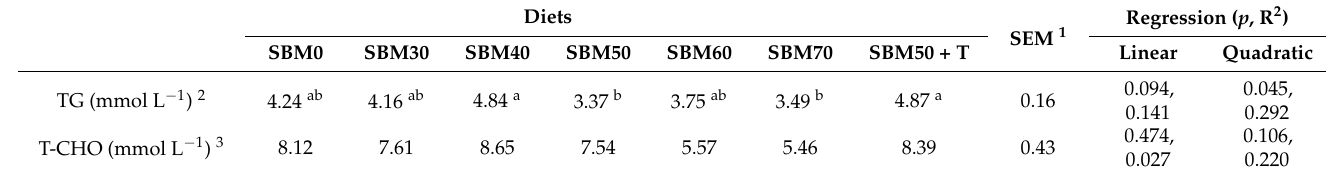
Table 9. Biochemical indices in the serum of juvenile Oplegnathus punctatus fed experimental diets for eight weeks.